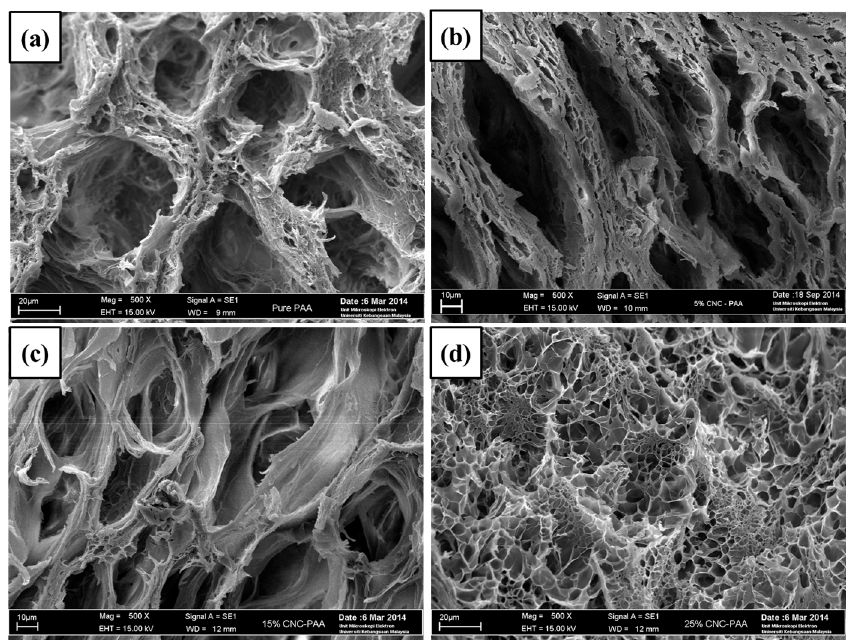
Figure 6. SEM micrographs of cross-section of ( a ) PAA hydrogel; ( b ) 5 wt % CNC/PAA hydrogel; ( c ) 15 wt % CNC/PAA hydrogel; and ( d ) 25 wt % CNC/PAA hydrogel.